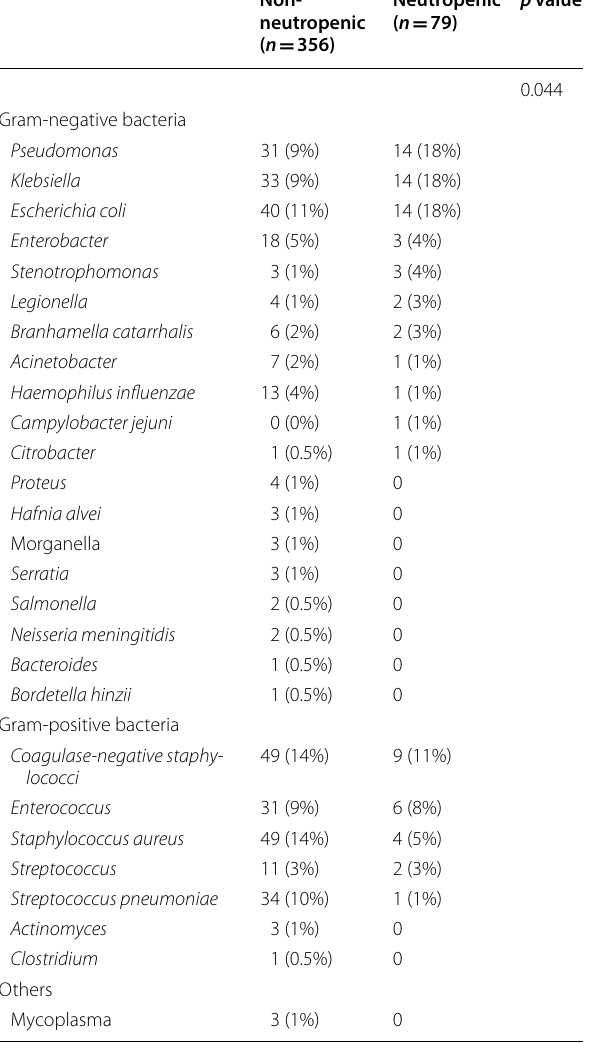
Table 3 Bacterial infectious